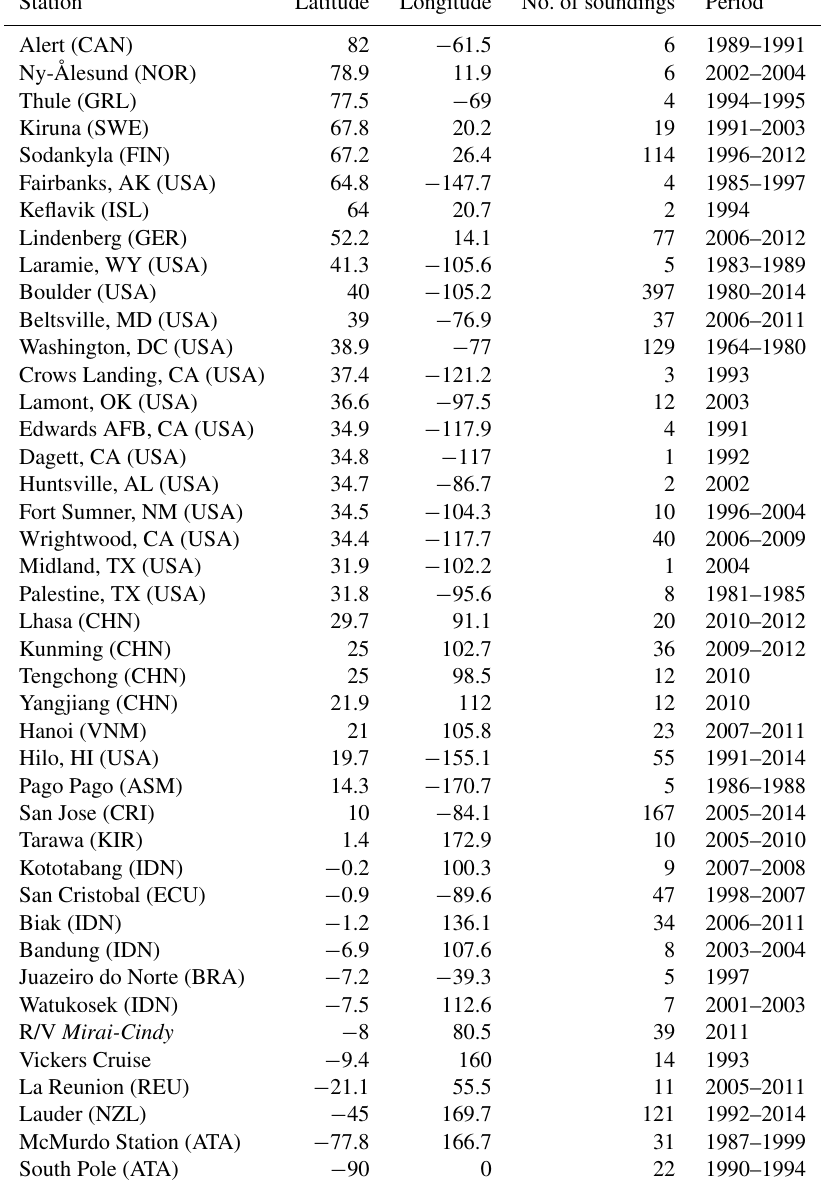
Table 2. Frost point hygrometer stations used in satellite water vapor